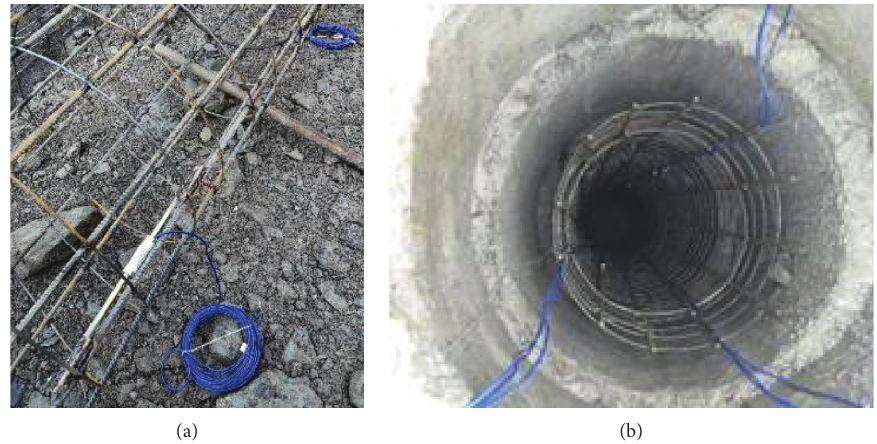
Figure 6: Site photo of strain gauges embedding. (a) Part photo. (b) The overall photo.